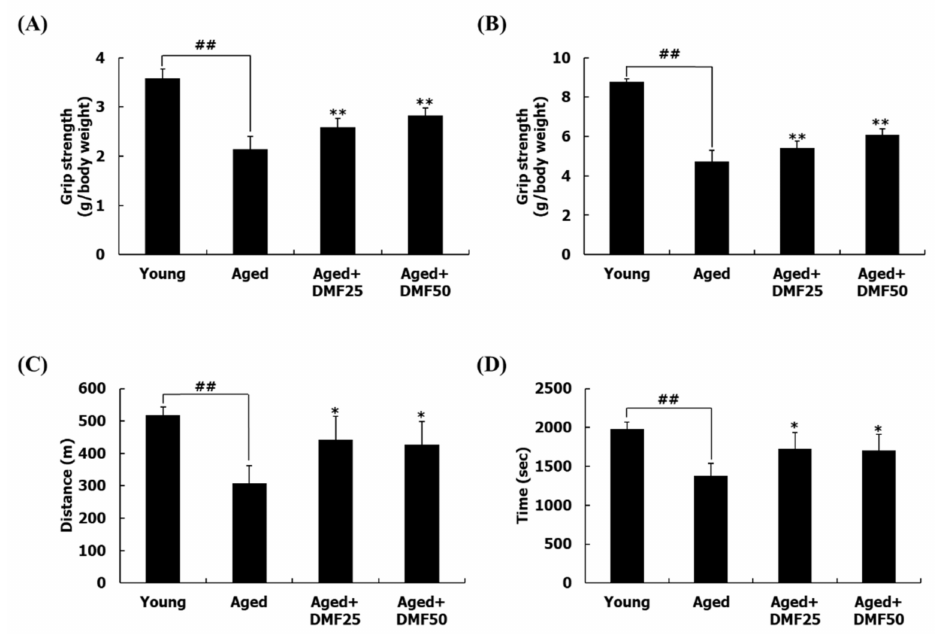
Figure 2. E ff ect of DMF on muscle function. ( A ) Forelimb strengths, ( B ) fore / hindlimb strengths. Grip strengths were normalized to the body weight. ( C ) Running distance, ( D ) running time. Results are presented as the mean ± SD; ## p < 0.01 vs. Young group; * p < 0.05, ** p < 0.01 vs. Aged